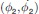
Examples of IPS observed in numerical simulations.For f
10 = 160 BPM and f
20 = 157.08915, we present (a) the time evolution of the phases, ϕ
1,2, where anti-phase synchronization is observed in the phase envelopes; (b) the phase trajectory in the (ϕ2,ϕ˙2) space; (c) the Poincaré maps; and (d) a magnified view of the Poincaré maps. (e) The variation of the phase difference Δr
ϕ at t = 1 × 104 as a function of the phase ratio r. Δr
ϕ reaches a minimum as r approaches r
1 = π / 3.1. (f) The time evolution of Δr
ϕ for r = r
1 (red) and r = r
1 − 4.17 × 10−4 (blue). (g) The variation of the phase difference Δr
ϕ at t = 1 × 104 as a function of r near r2=37/6. (f) The time evolution of Δr
ϕ for r = r
2 (red) and r = r
1 − 7.93 × 10−4 (blue).